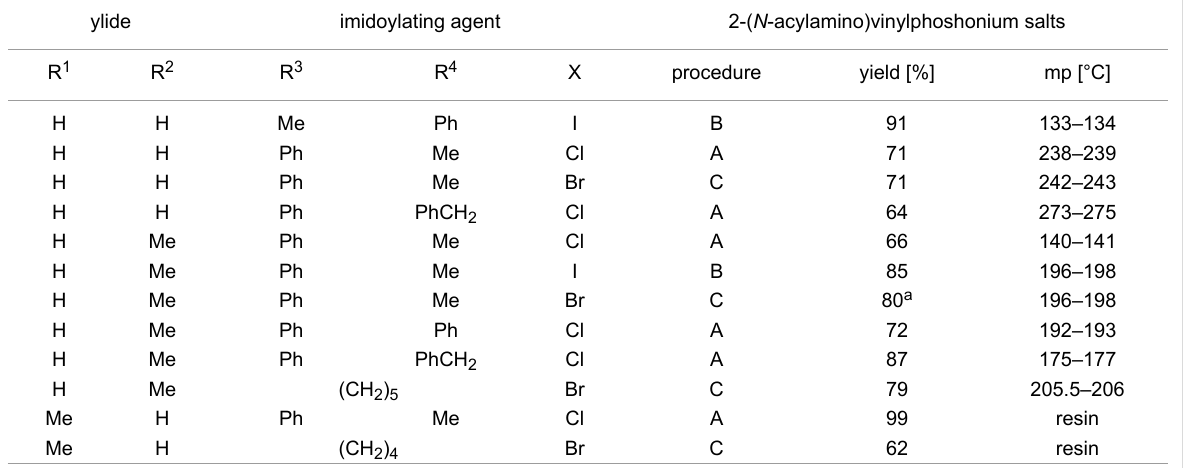
a A mixture of stereoisomers in the ratio of 68:32.